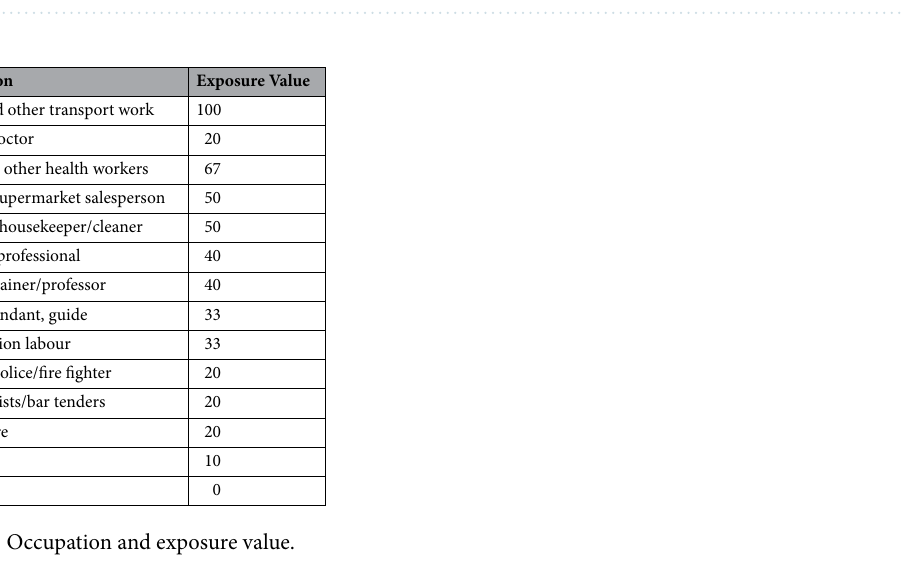
Table 3. Symptoms and corresponding relative percentages.